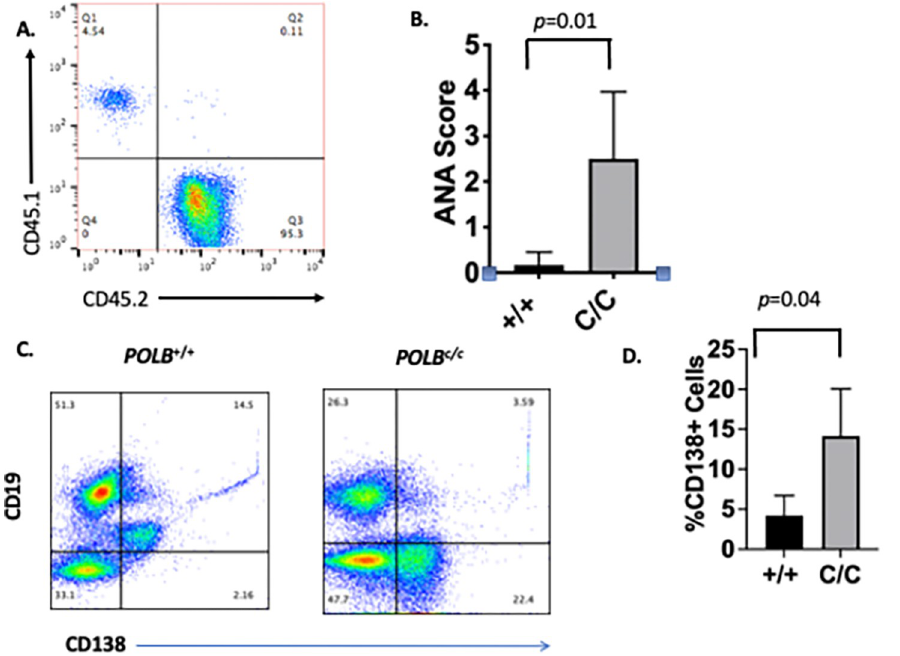
Fig 1. Mice engrafted with bone marrow from the POLB Y265C/C mice develop high levels of antinuclear antibodies. A. Representative example of a FACs plot demonstrating successful engraftment of bone marrow cells in the Pep Boy mice from the POLB Y265C/C donor. Similar results were observed when the POLB +/+ mice served as donors. B. ANA scores of sera from POLB +/+ and POLB C/C mice. C. Representative example of a FACs plot showing increased levels of CD138 + plasma cells isolated from the blood of the POLB +/+ and POLB C/C mice. D. Quantification of CD138 + cells. T- tests were used to determine if the means of each of the two groups were significantly different from each other.